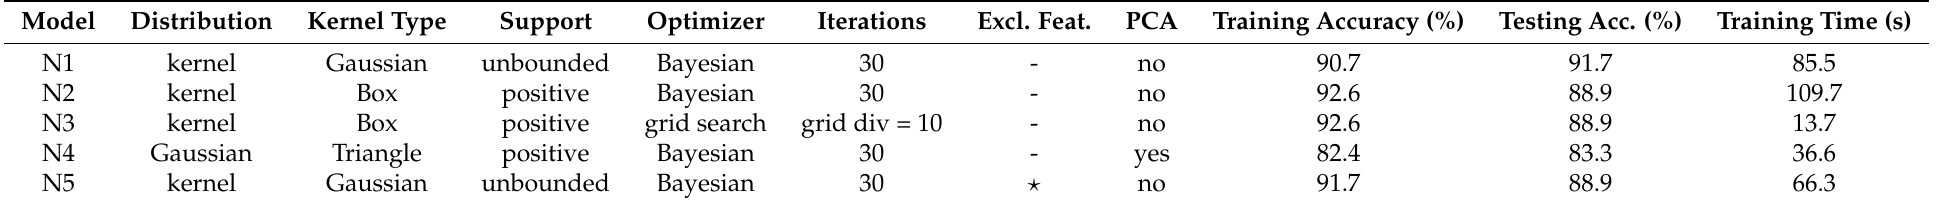
Table 7. Features of the NB models, and relevant accuracies achieved. Excl. feat. = excluded features ( (cid:63) = top/bottom geometry, diagrid total length, maximum normal force).